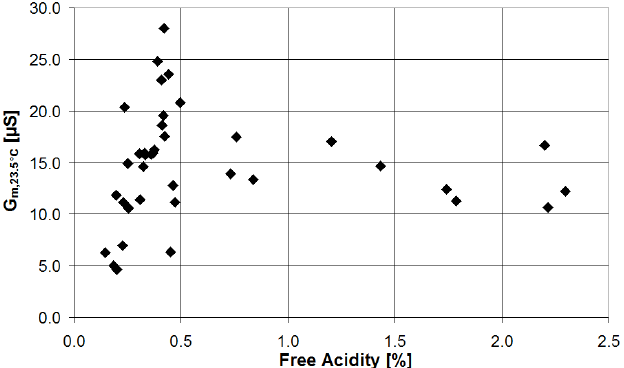
Figure 8. Emulsion electrical conductance at 23.5 °C using the DW reagent as function of free acidity for the full set of 40 olive oil samples.